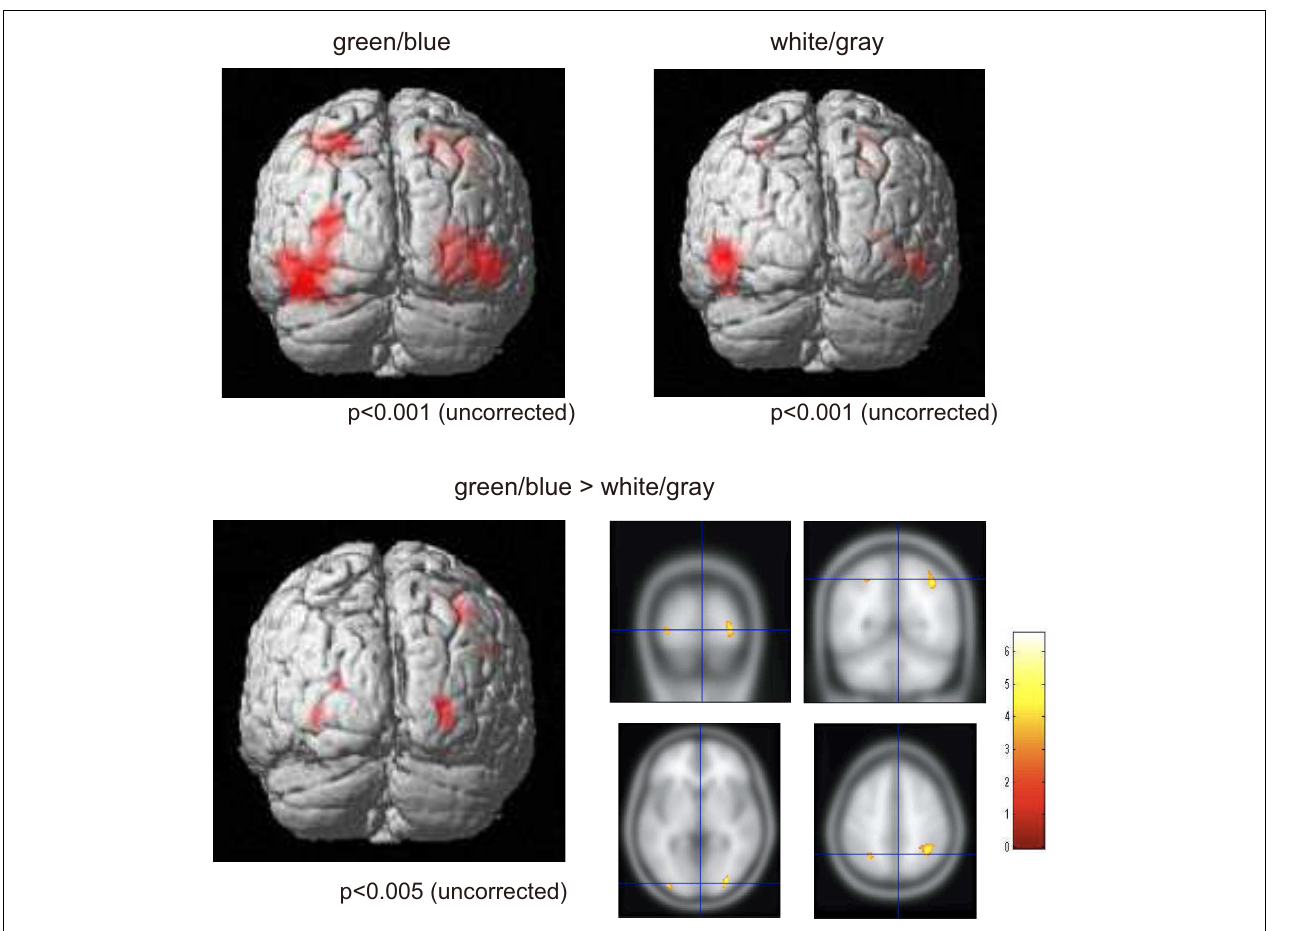
the green/blue condition than under the white/gray condition ( P < 0.005, uncorrected). Note that the activation foci detected by the fMRI analyses were located close to the areas in which the peak ERP amplitudes in response to the target stimuli were significantly higher under the green/blue than under the white/gray